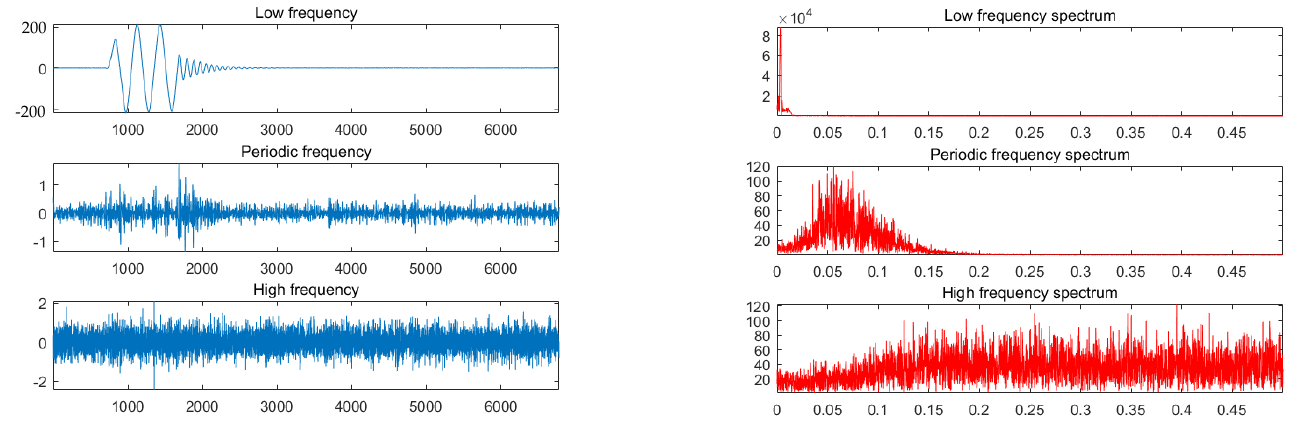
Figure 8. Reconstructed signal and spectrum of Line 2.